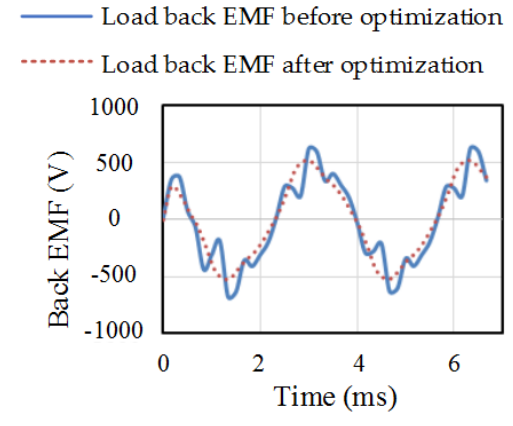
Figure 13. Back EMF of the AFPMSM at the rated load power.